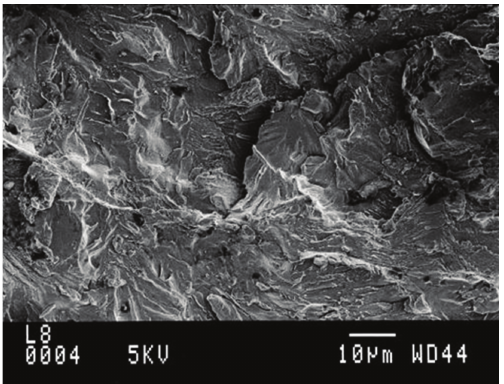
Figure 17: A scanning electron micrograph of the fractured surface of a slow strain-rate specimen tested in 25% CO at 45 ◦ C and 800 kPa total